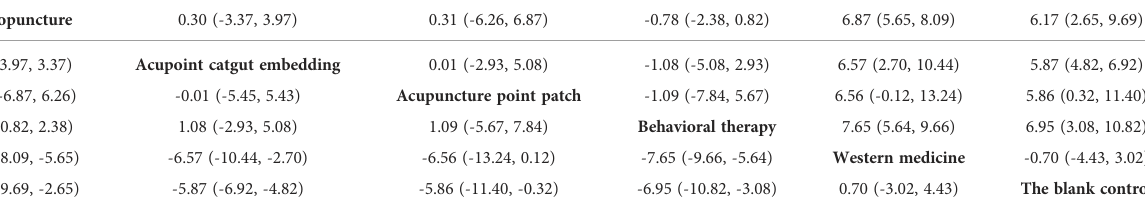
TABLE 3 Network meta-analysis ladder table of fasting serum